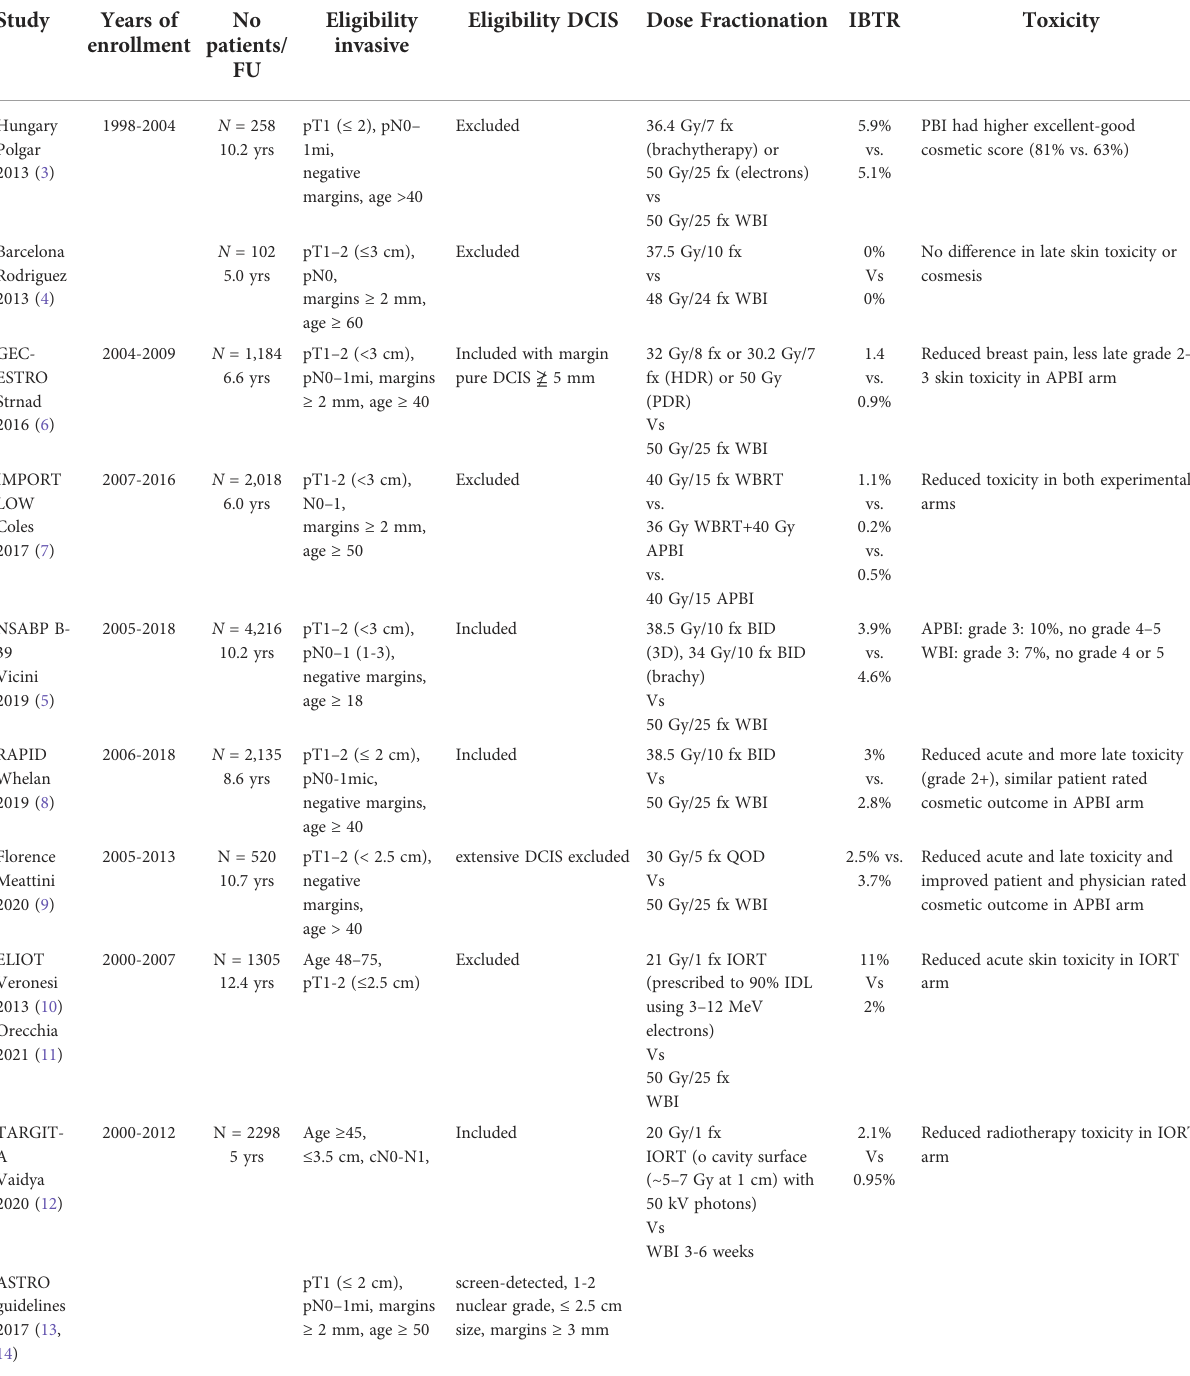
TABLE 1 Summary of key APBI